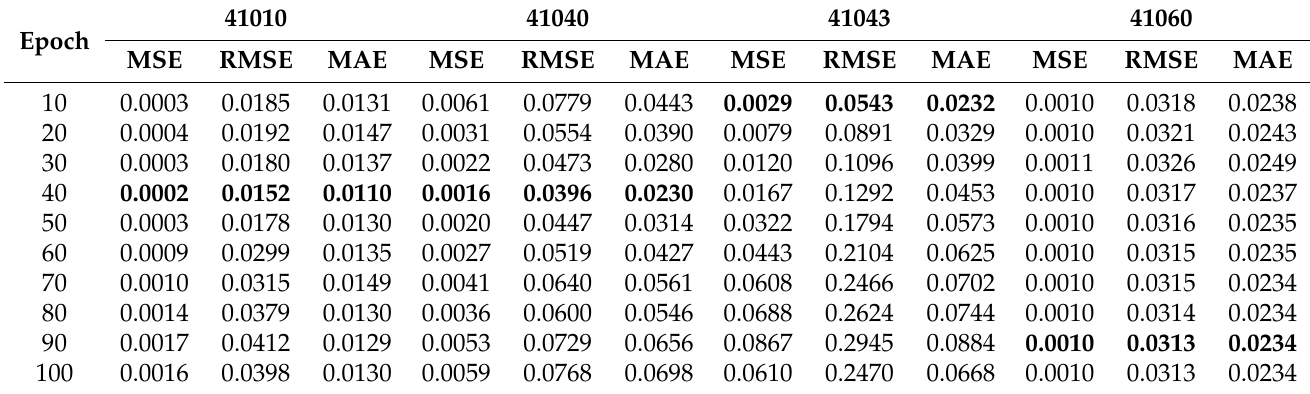
Table 5. Results of the proposed VRNN-SCA model in all